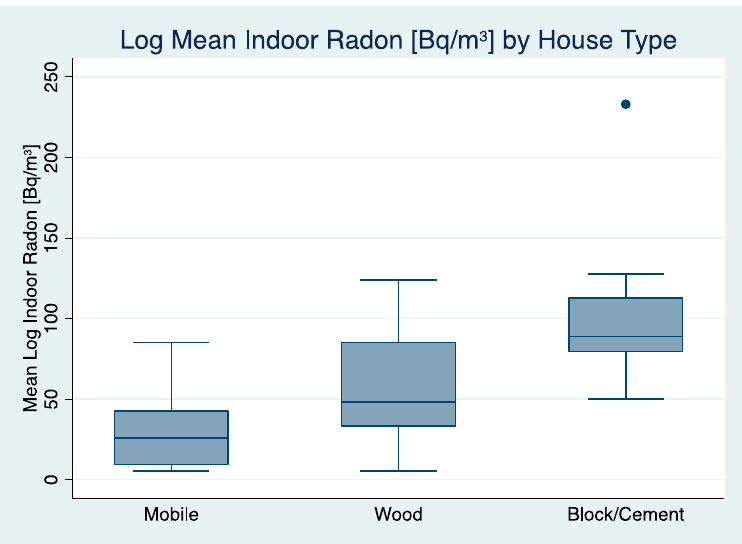
Figure 3. Log Mean Indoor Radon Concentration [Bq/m 3 ] by House Type (Hogan and Mix “Cement/Wood” houses not included due to small sample size).